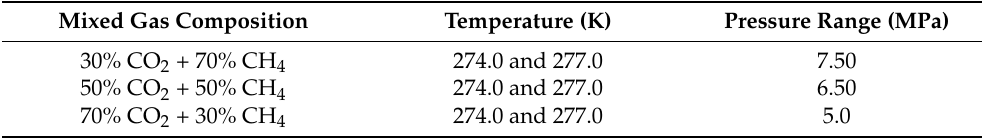
Table 2. Details of KHI experimental conditions encountered in gas transmission lines for various gases with or without aqueous QAHs